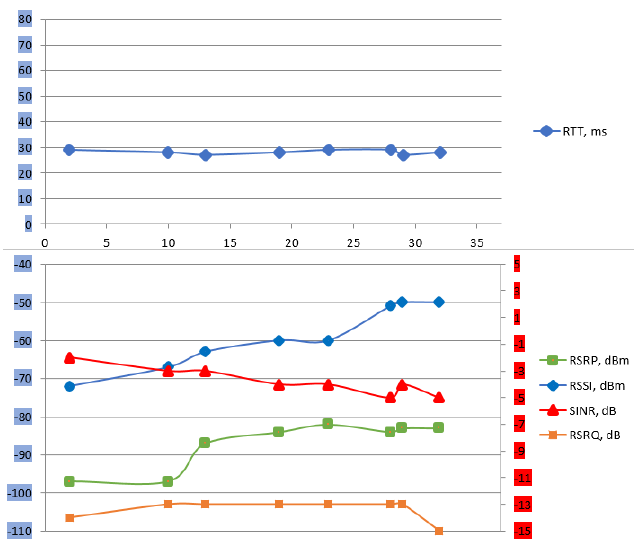
Fig. 6. Network performance for the static UE at different altitudes in 3G LTE mode of